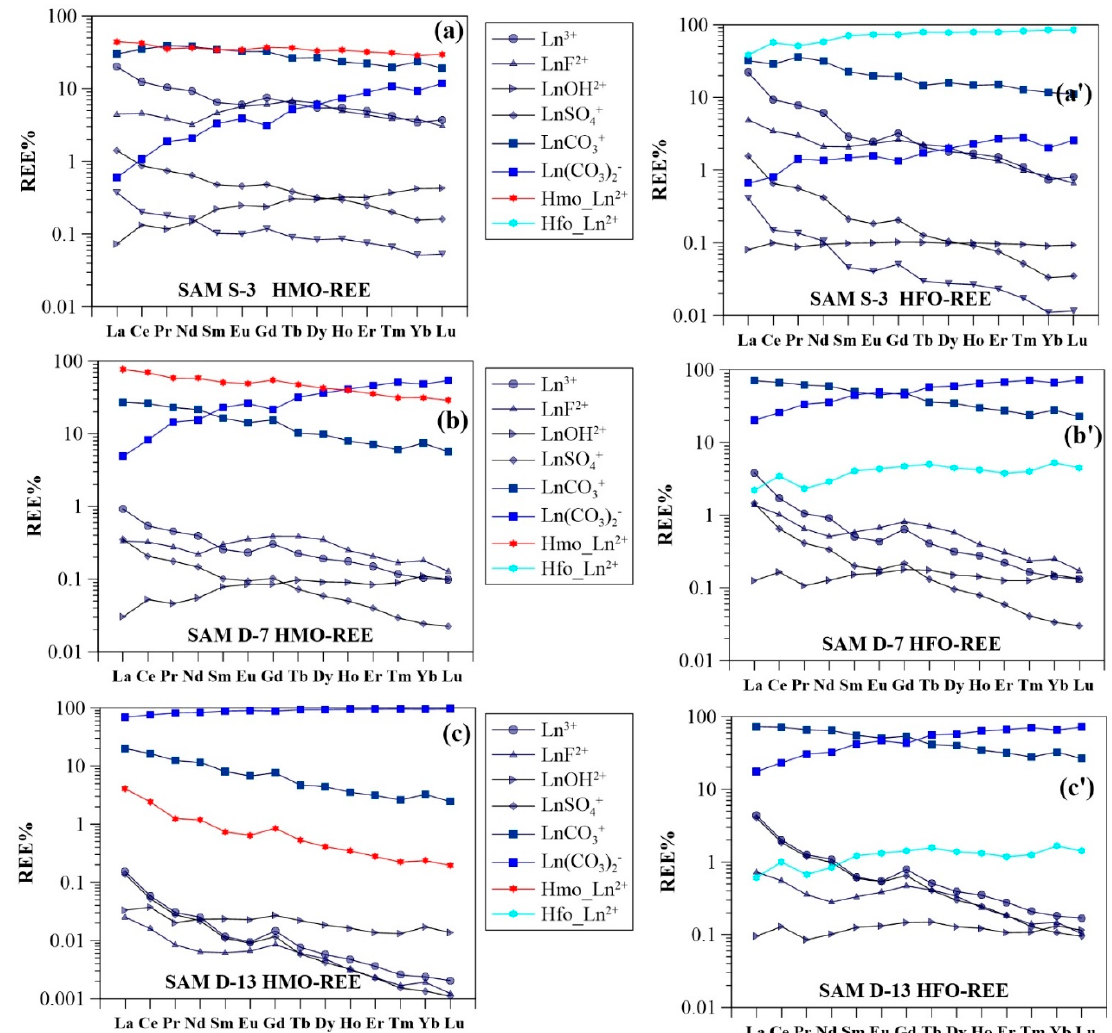
Figure 4. Results of REE speciation modeling (Ln represents any of the REE). ( a ) sample S-3 considering HMO; ( a’ ) sample S-3 considering HFO; ( b ) sample D-7 considering HMO; ( b’ ) sample D-7 considering HFO; ( c ) sample D-13 considering HMO; ( c’ ) sample D-13 considering HFO.